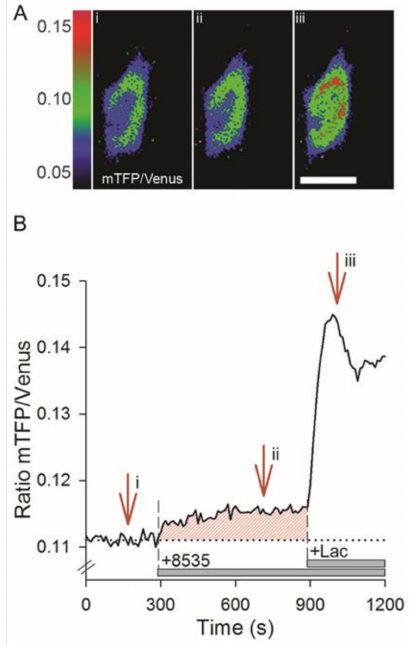
Figure 1. Effect of 3T3 cell stimulation with 8535, a surrogate agonist of GPR27 on [lactate] i . ( A ) Pseudo-colored micrographs display changes in the mTFP/Venus ratio of the lactate sensor Laconic in a single 3T3 cell, reporting cytosolic levels of L-lactate ([lactate] i (FRET ratio, see Methods). Laconic expression is predominantly present in the cytoplasm. Representative images display a 3T3 cell at the beginning of experiment ( i ) and after application of 1 µ M 8535 ( ii ) and 20 mM L-lactate ( iii ). Extracellular L-lactate was applied as a positive control to test if the Laconic sensor is functionally expressed in the 3T3 cells (i.e., responds to intracellular L-lactate elevations). Scale bar, 20 µ m. ( B ) The mTFP/Venus ratio acquired from a time series of micrographs of the cytoplasmic region of the cell in ( A ). Note the increase in the signal after the application of 8535 and extracellular L-lactate, 20 mM (+Lac; horizontal bar). The arrows denote the frames shown in ( A ). The red-striped area denotes the area under the